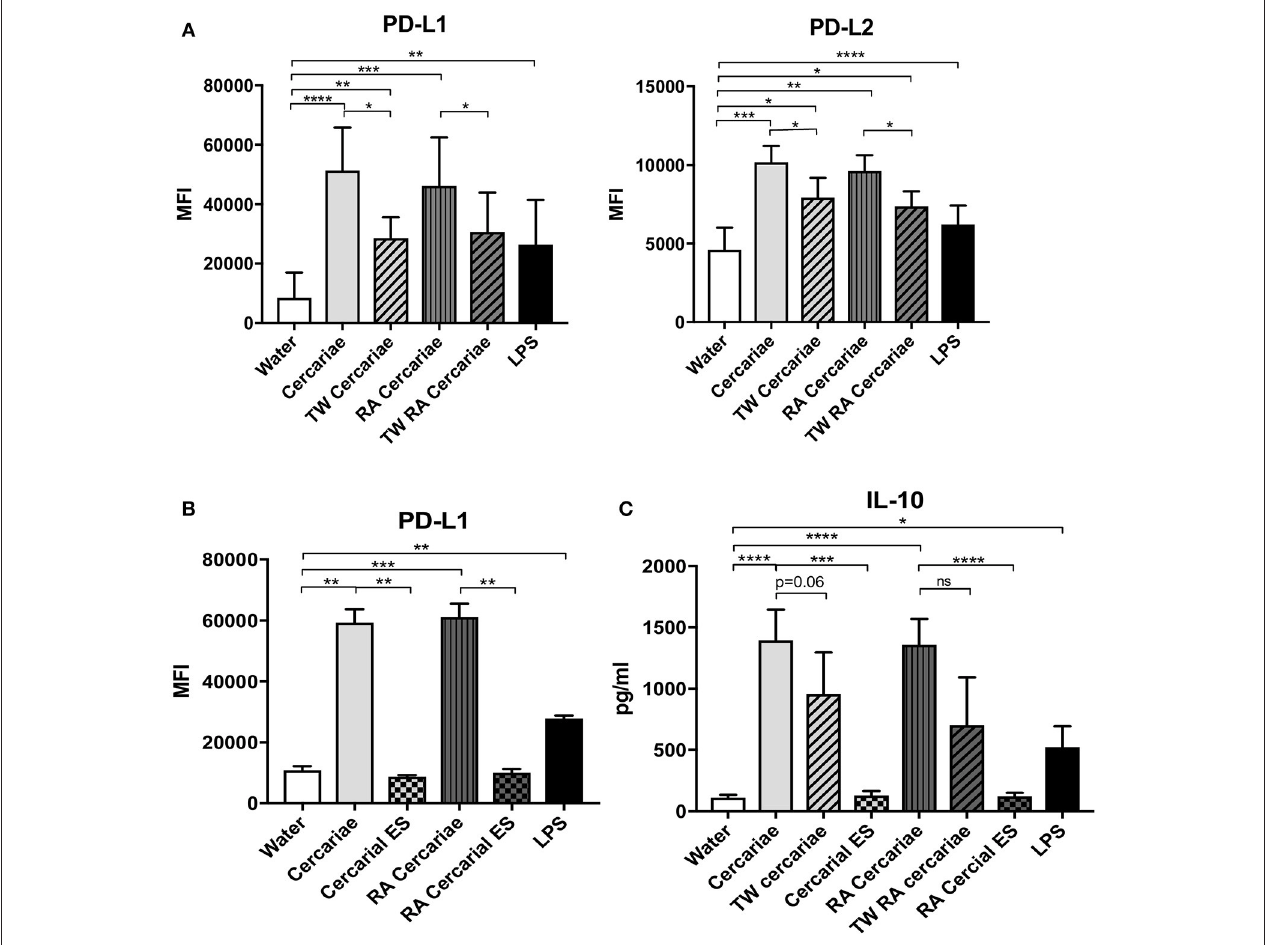
FIGURE 8 | Direct contact with cercariae but not cercarial ES products increases immunoregulatory markers PD-L1 and 2 and IL-10 secretion. PD-L1 and PD-L2 up regulation after cercaria stimulation in presence or absence of direct contact (TW = transwell) (A) . PD-L1 expression after stimulation with cercariae or cercarial ES alone. The ES dose was matched to the number of cercariae used for stimulation ( B ). IL-10 production of MoDCs after stimulation with cercariae or their products (C) . Mean ± SEM. * p < 0.05, ** p < 0.005, *** P < 0.0005, **** p < 0.0001 using paired student’s T -test (on log transformed data for